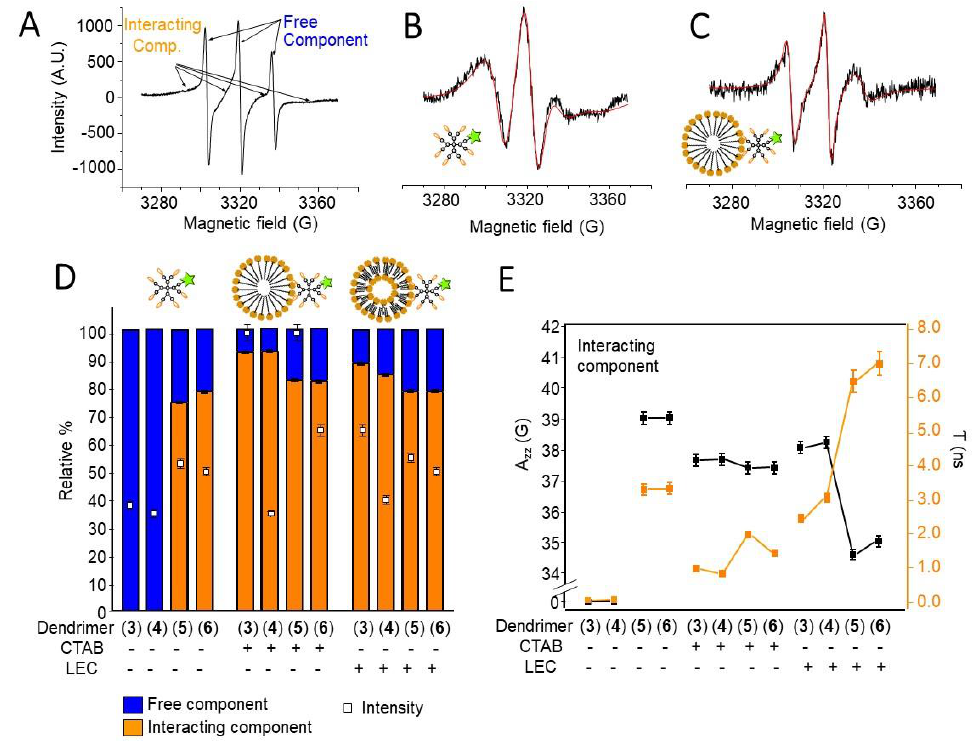
Figure 2. Experimental spectra and computation spectra / parameters for the EPR spectra of the labelled dendrimers G n -PyT and G n -RuT 3 – 6 in the absence and presence of the model membranes (cetyltrimethylammonium bromide micelles (CTAB) and lecithin liposomes (LEC)). ( A ) Experimental EPR spectrum of G 1 -RuT ( 5 ) in Phosphate Buffered Saline , selected as an example. Arrows indicate the main features of the two components constituting the spectra (termed Free and Interacting); ( B,C ) experimental and computed Interacting components of G 1 -RuT ( 5 ) alone or in the presence of CTAB, obtained after subtraction of the Free component. The spectra are normalized in height. ( D ) Total intensity of the EPR spectra (squares, assuming I = 100% for the spectrum of the labelled dendrimers in the absence of model membranes) and relative percentage of Interacting component (bars). ( E ) Polarity parameter, A zz , and microviscosity parameter, τ, for the Interacting component. The occurrence of both components allowed us to perform subtractions between spectra to extract each of the components and also evaluate, by double integration of the components, their relative percentages. The components were then also computed to extract parameters providing structural and dynamical information (Table 1, see the experimental section for details). Figure 2B,C show as examples the experimental and computed Free and Interacting components for G 1 -RuT ( 5 )